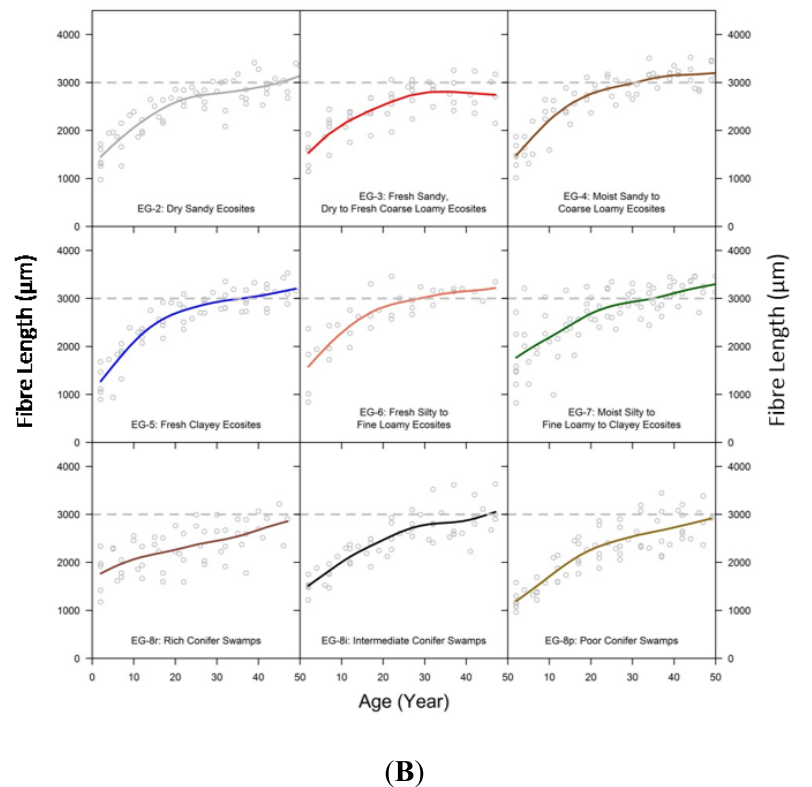
Figure 2. Mean fibre lengths for the earlywood ( A ); and latewood ( B ) of annual rings plotted against tree age at breast height for black spruce increment cores collected from the boreal forest of north eastern Ontario from 2010–2011. The fibre length—age relationship was fit with a cubic smoothing spline for each of nine ecosite groups. The dashed horizontal line indicates a threshold fibre length value of 3000